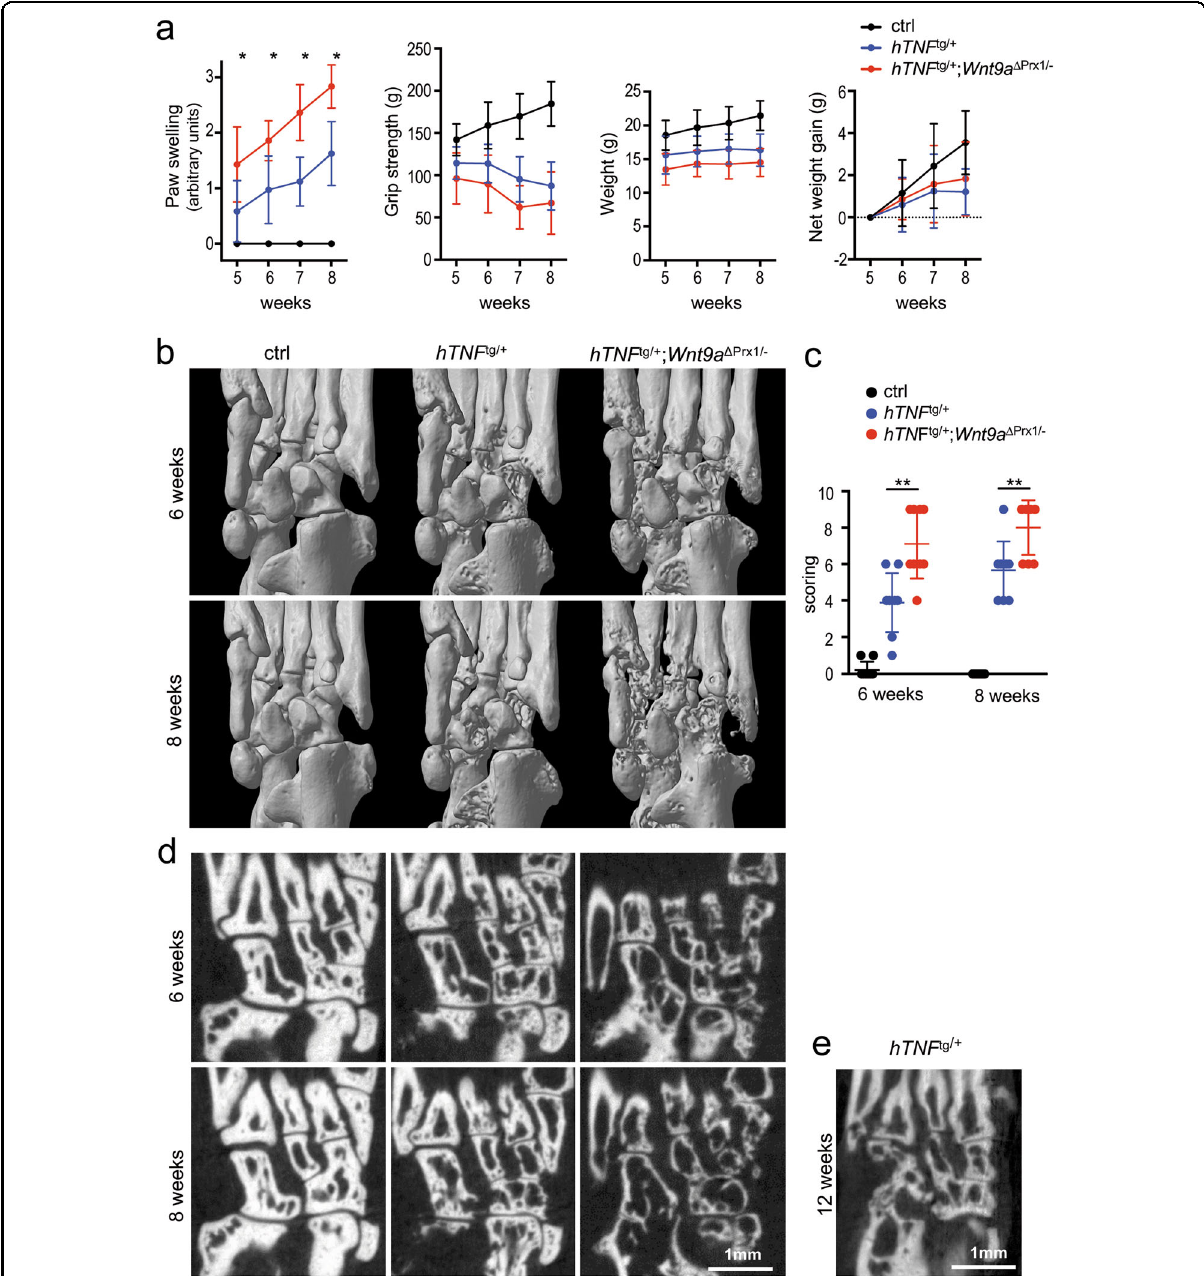
Fig. 2 Wnt9a -de fi ciency worsens clinical parameters of experimental arthritis and promotes bone destruction in hTNF transgenic mice. a Assessment of disease progression by measurement of paw swelling, grip strength, and weight in control (ctrl), hTNF tg/ + , and hTNF tg/ + ; Wnt9a Δ Prx/ − mice over 5 – 8 weeks. The net weight gain in the hTNF tg/ + and hTNF tg/ + ; Wnt9a Δ Prx/ − mice was similar. Data are presented as the mean ± SD (ctrl: n = 19; hTNF tg/ + : n = 34; hTNF tg/ + ; Wnt9a Δ Prx/ − : n = 21 for the 5- and 6-week timepoints, and ctrl: n = 9; hTNF tg/ + : n = 25; hTNF tg/ + ; Wnt9a Δ Prx/ − : n = 12, for the 7- and 8-week timepoints). b Representative three-dimensional microCT images of ctrl, hTNF tg/ + , and hTNF t g/ + ; Wnt9a Δ Prx/ − hind paw regions at the 6- and 8-week timepoint ( n = 9). c Scoring of the three-dimensional microCT images with regard to the extent of bone destruction (arbitrary units) ( n = 9). d Two-dimensional representative microCT images of ctrl, hTNF tg/ + , and hTNF tg/ + ; Wnt9a Δ Prx/ − hind paw regions at the 6- and 8-week timepoint ( n = 9). e For comparison, a two-dimensional representative microCT image of the hTN F tg/ + hind paw region at a 12-week timepoint ( n = 3). P -values: *<0.05,